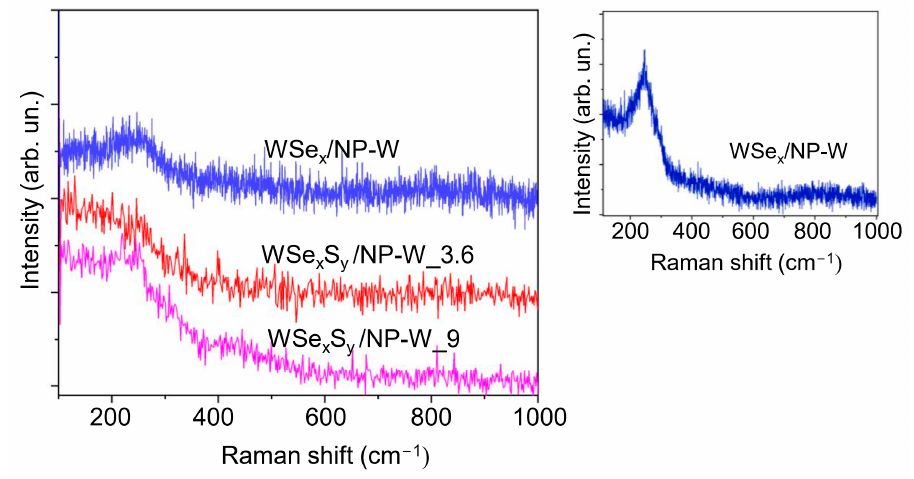
Figure 4. Raman spectra of WSe x /NP-W and WSe x S y /NP-W coatings measured with a laser intensity of 2 mW. The inset demonstrates that the use of laser irradiation with an intensity of 5 mW caused structure modification of the coating.